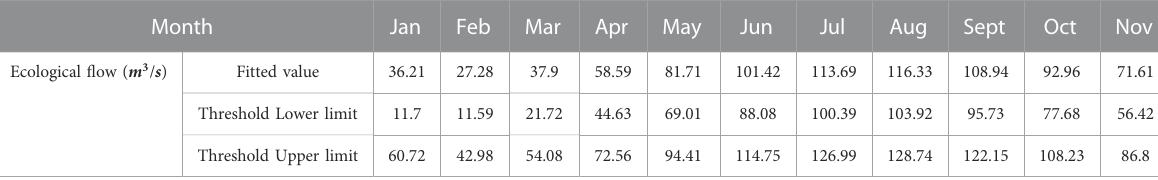
TABLE 7 Upper and lower threshold of the ecological fl ow.